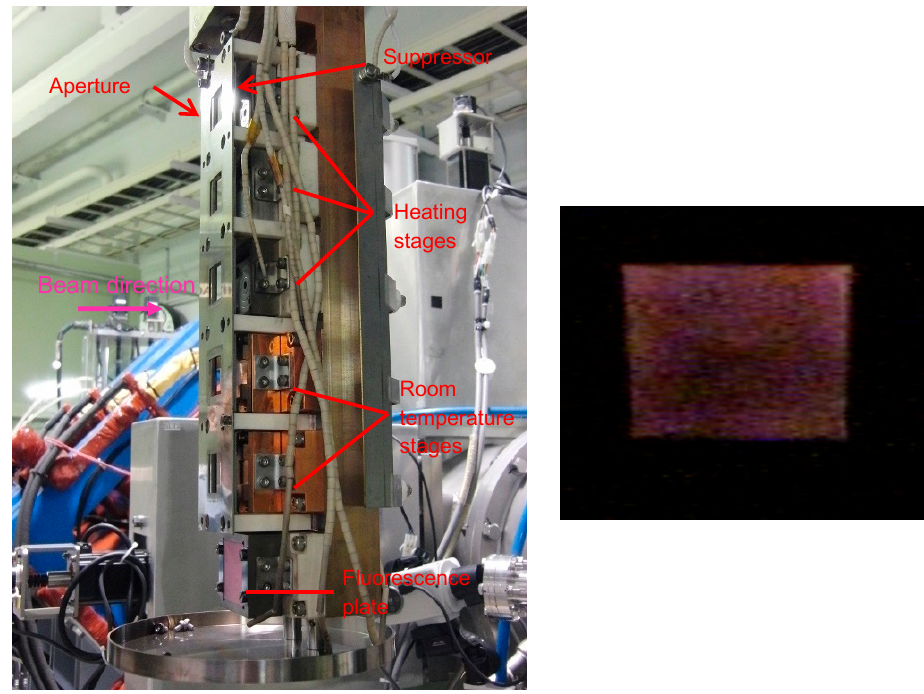
Figure 8. Sample stages ( left ), and captured image of the fluorescence plate for beam irradiation ( right ).